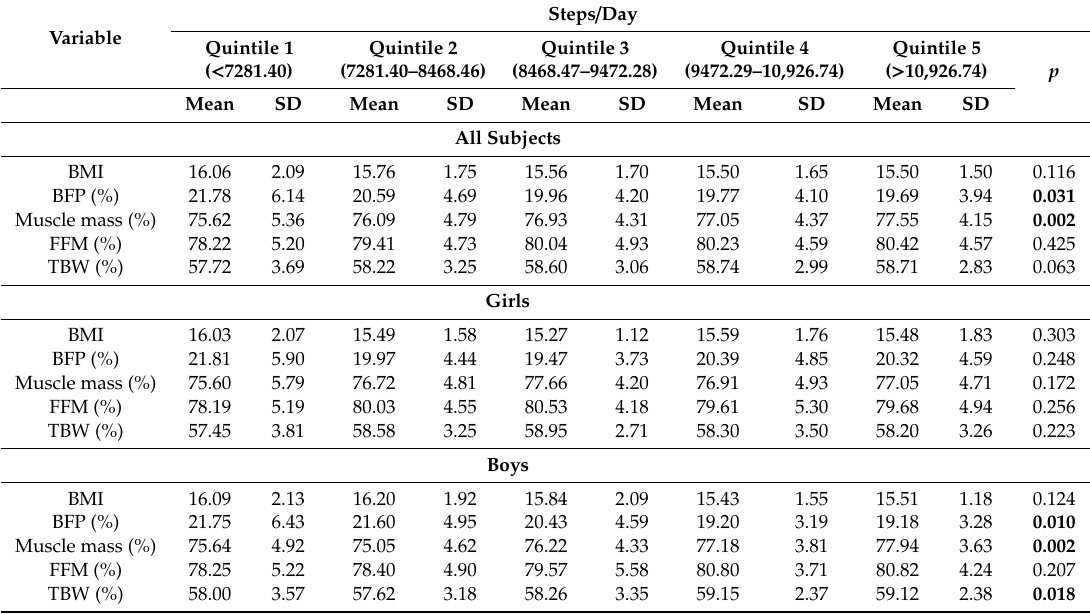
Table 7. Body composition indices according to the quintiles of steps per